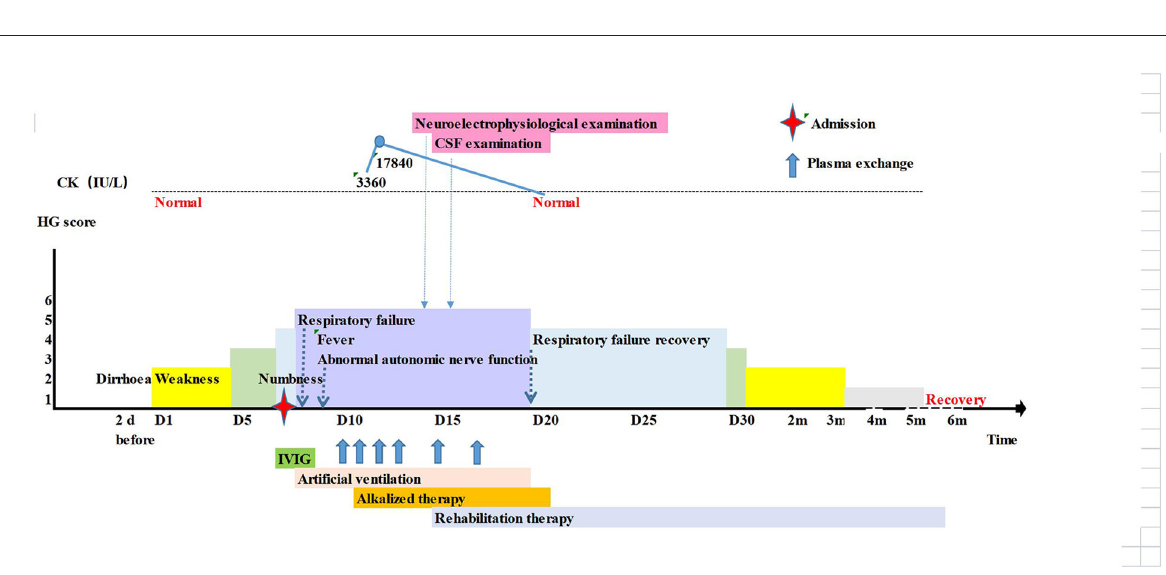
Final diagnosis: (1) Guillain-Barré syndrome (acute motor sensory axonal neuropathy, AMSAN), complicated with III, IV, V, VI, VII, IX, X and XI cranial nerve paralysis; (2) III